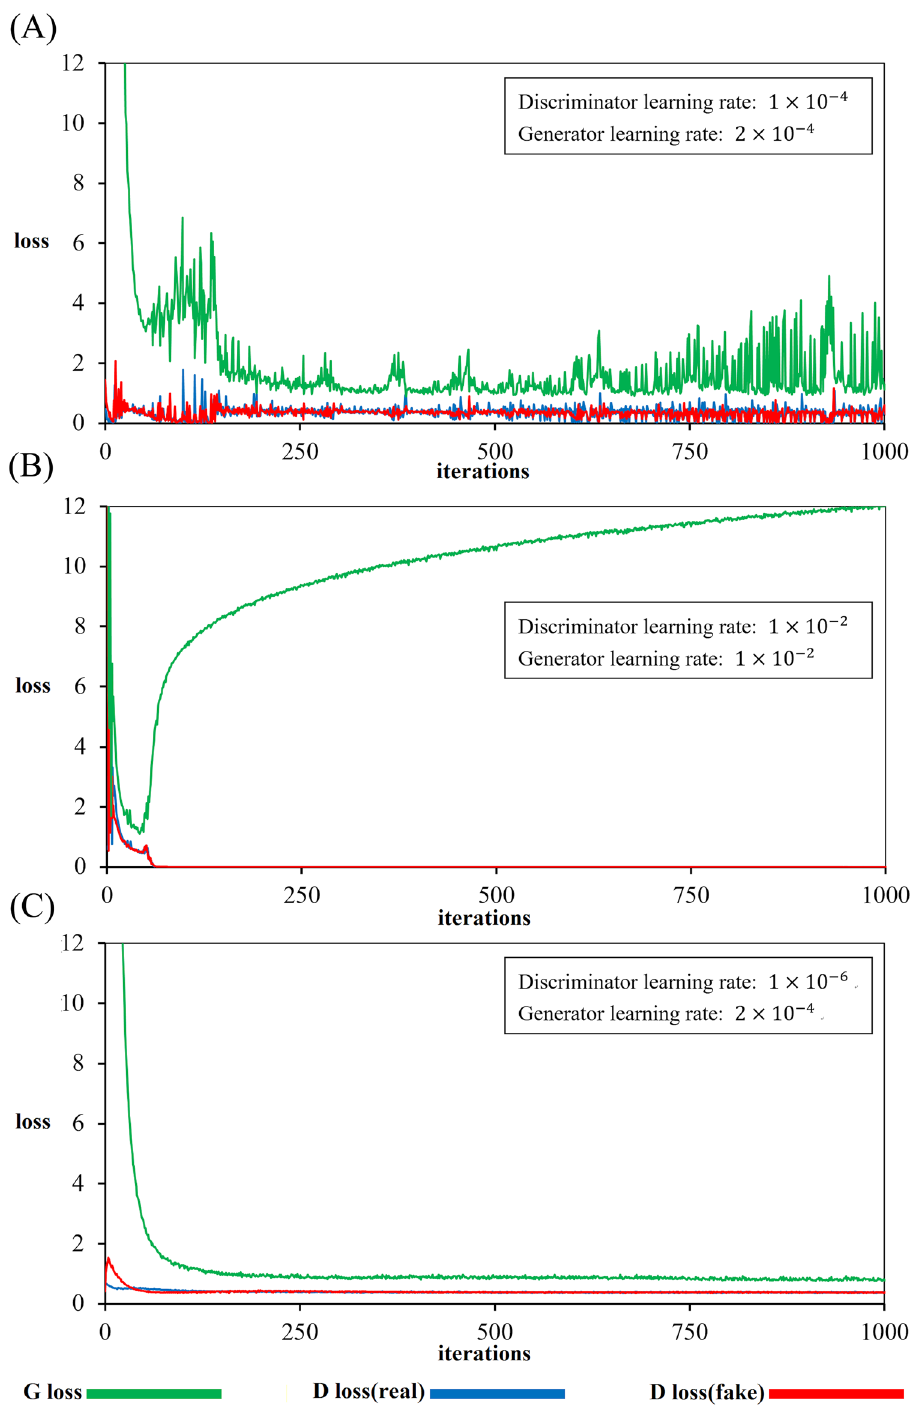
Figure 1. Effects of the learning rate on the training loss over iterations. ( A ) When the losses of the generator and discriminator strongly interact with each other, the outcome describes vibrations. ( B ) When the loss of the generator diverges, the model breakdowns, and the prediction from the model worsens. ( C ) With a proper learning rate, the loss smooth converges with stable results. The green line is the (cid:31) L L 1 ( G ) + E c loss. The red and blue lines are cGAN losses formulated as E c , x and E c , respectively. The curve is for the GE-EPI-only